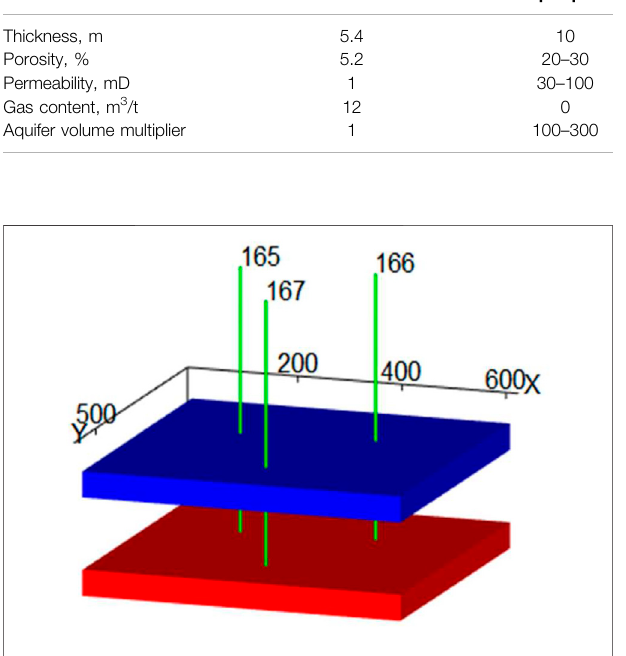
FIGURE 3 | Three-layer mechanism model of the aquifer, sealing layer, and coal seam.